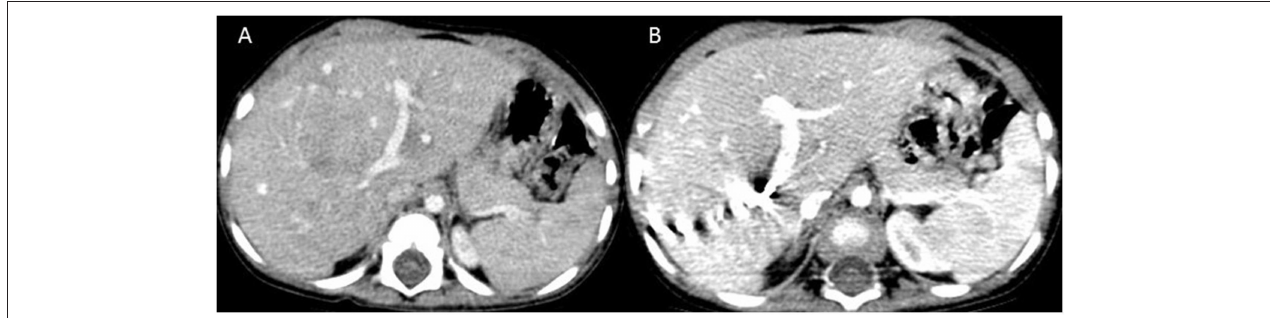
FIGURE 1 | Computed tomography images at the level of splenic hilum before (A) and after (B) portal vein embolization showing hypertrophy of segment